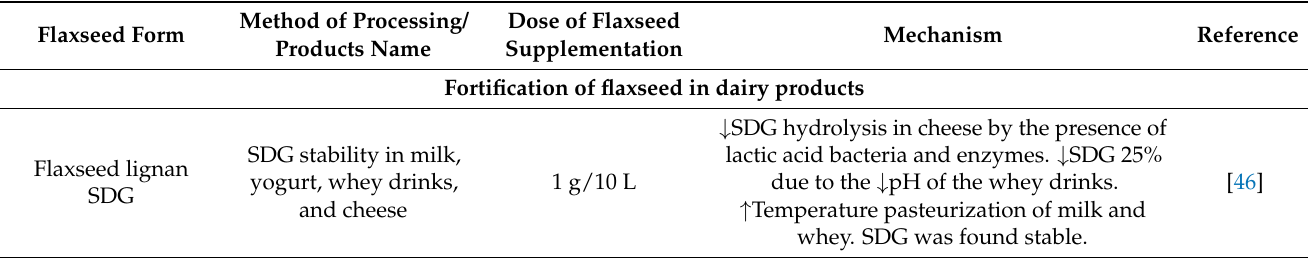
Table 2. Food applications of flaxseed, its by-products, and bioactive